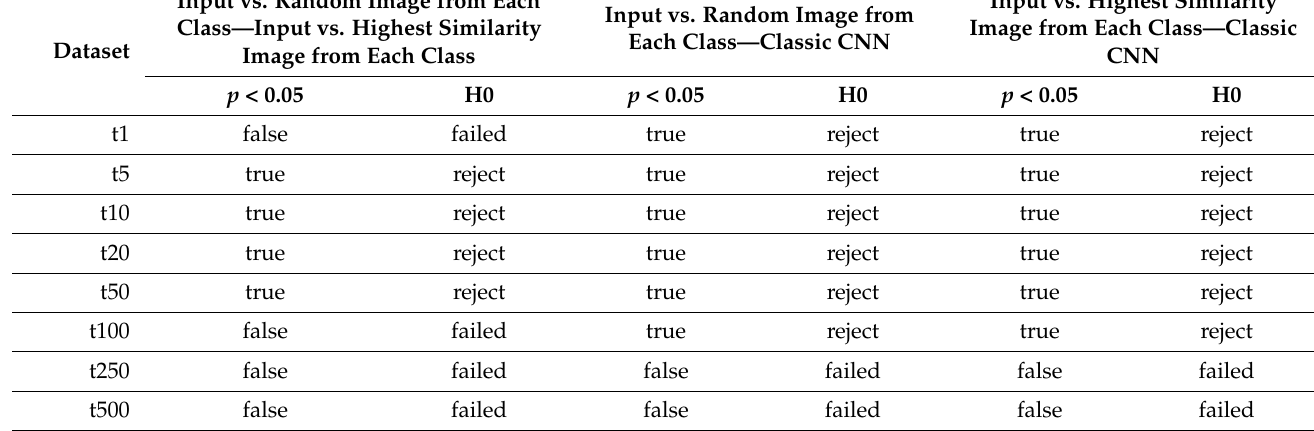
Table 8. The McNemar’s test with a significance level of 0.05. The results are in accordance with the classification results from Table 7.